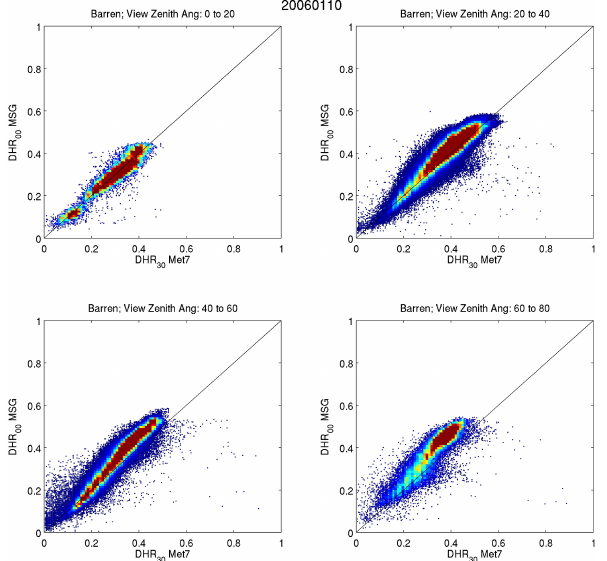
Figure 6. Scatter plots of MSA DHR30 ( x axis) vs. SEVIRI DHR ( y axis) for pixels classified as “barren” for the 1–10 January 2006 period. Pixels are grouped according to MSA viewing angle ranges indicated in the top of each panel.